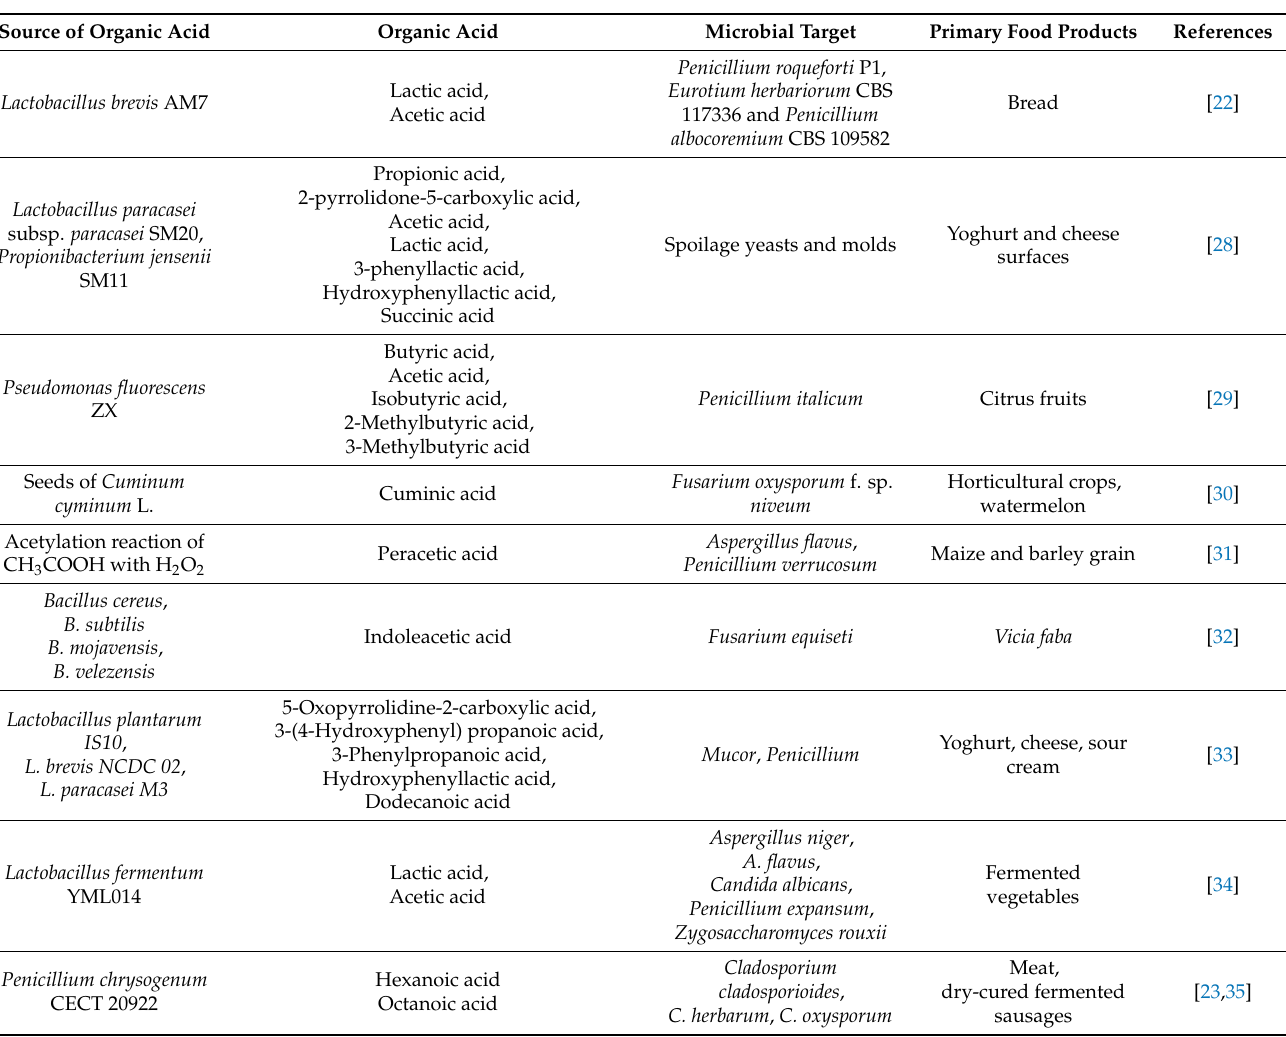
Table 1. Major organic acids as an antifungal agent and targeted fungal